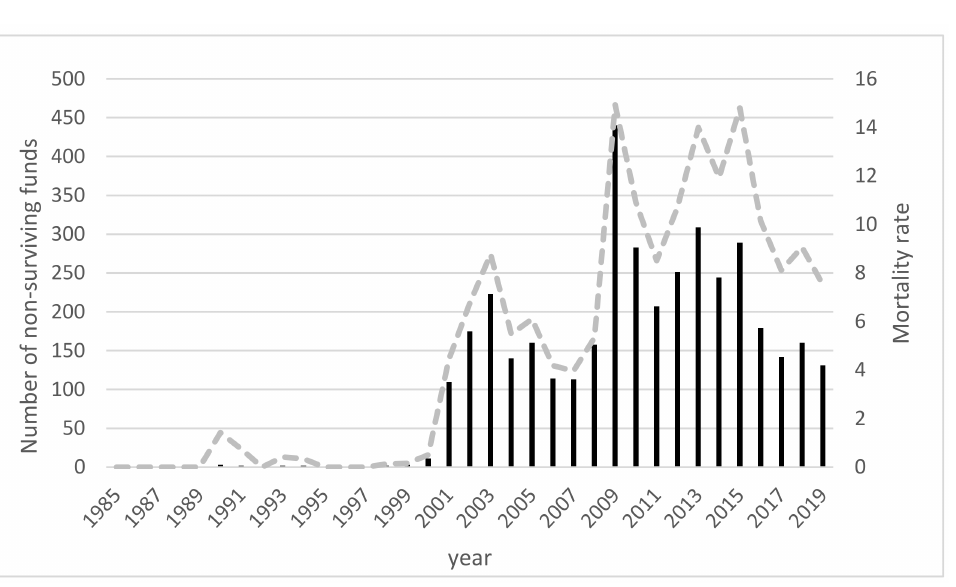
Figure 1. Evolution of the number of non-surviving funds in the Spanish market,